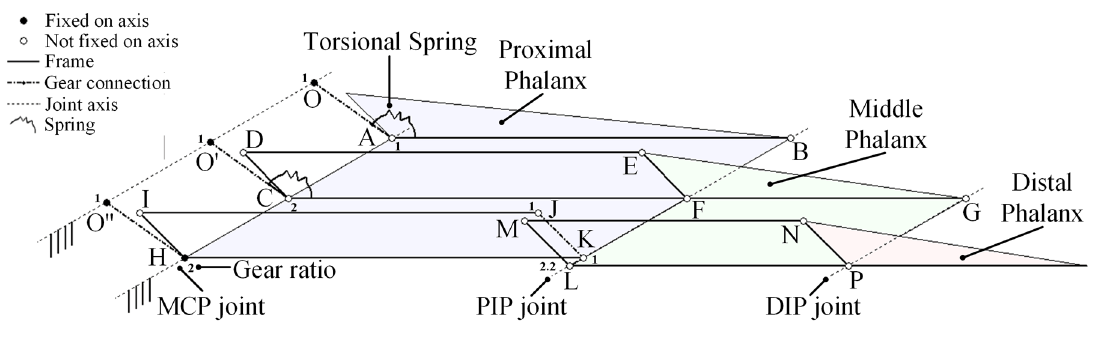
Figure 3. Schematic of the structure of the finger module.